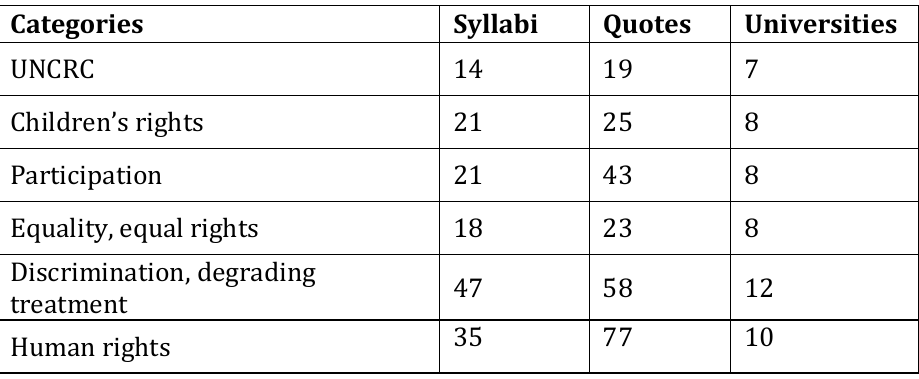
Table 1. Terms found in Syllabi Children’s Rights and the